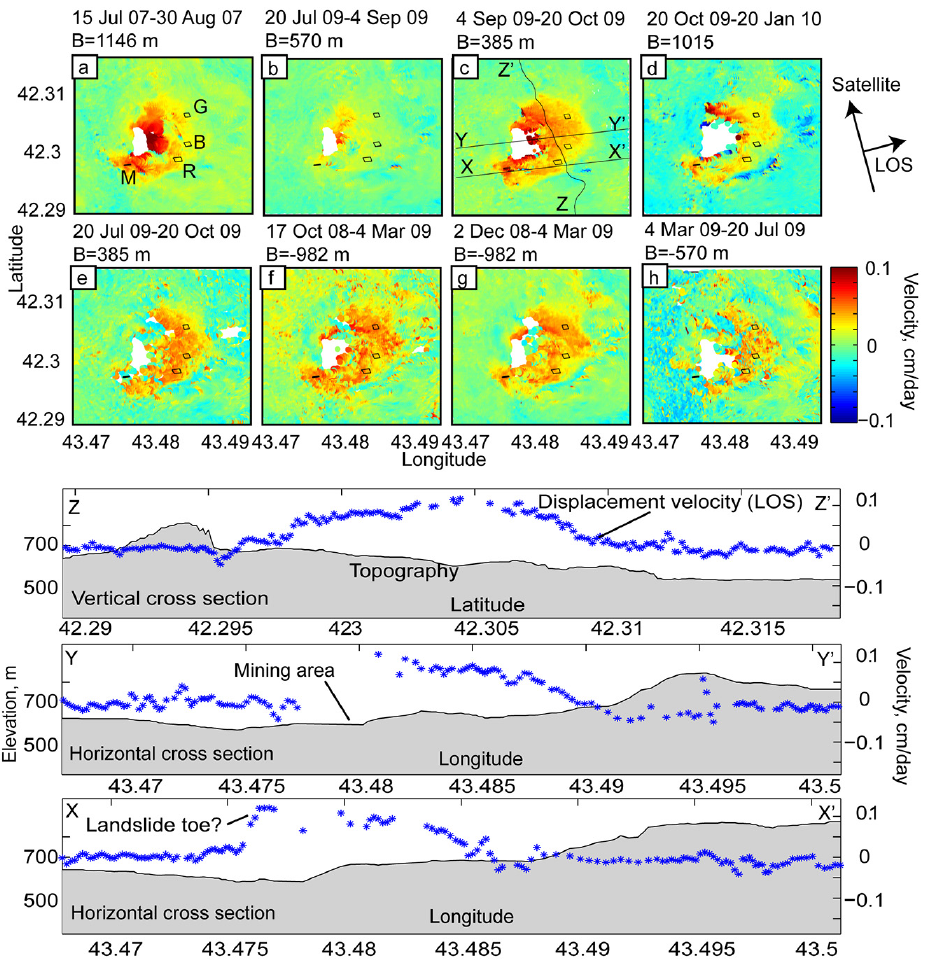
Fig. 4. Velocity (cmday − 1 ) in the line-of-sight (LOS) direction from InSAR data. Given above each image are the two acquisition dates and the spatial baselines (B). Interferograms that are temporally or spatially decorrelated are not shown. Black lines show the profiles on plot (c) , for which the topography and displacement velocities are shown below (Z-Z 0 , Y-Y 0 , X-X 0 ). Polygons are marked with the letters “G”, “B”, “R” and “M” (panel a ) and present areas where average velocities were calculated for Fig.